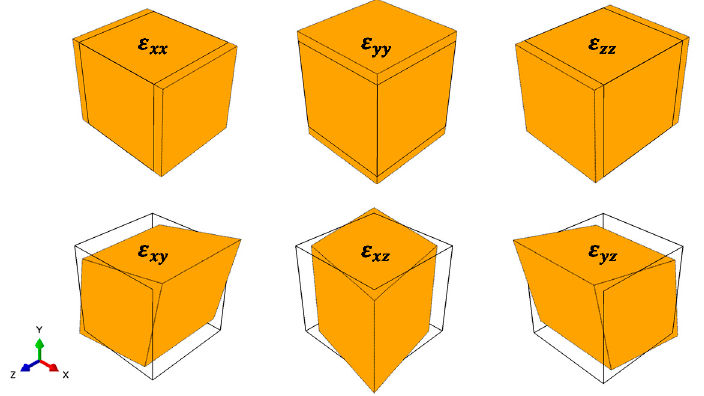
Figure 3. Schematic diagram of a finite element model for RVE perturbation analysis.